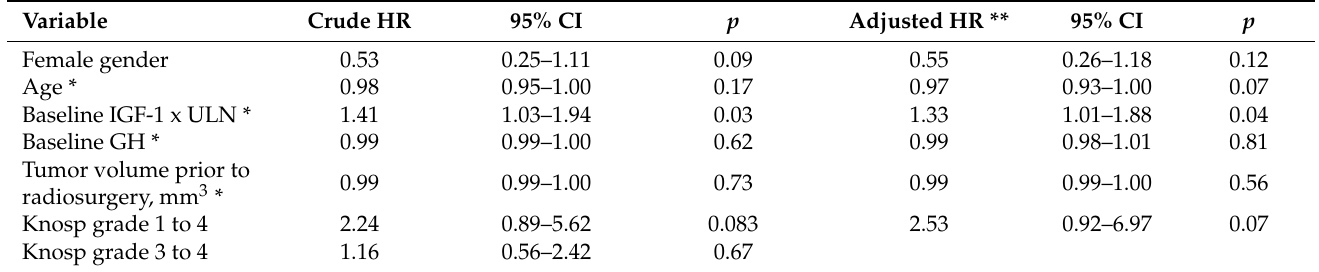
Table 4. Cox Proportional Hazards Regression Analysis for the absence of biochemical remission of the disease after radiosurgery ( n =